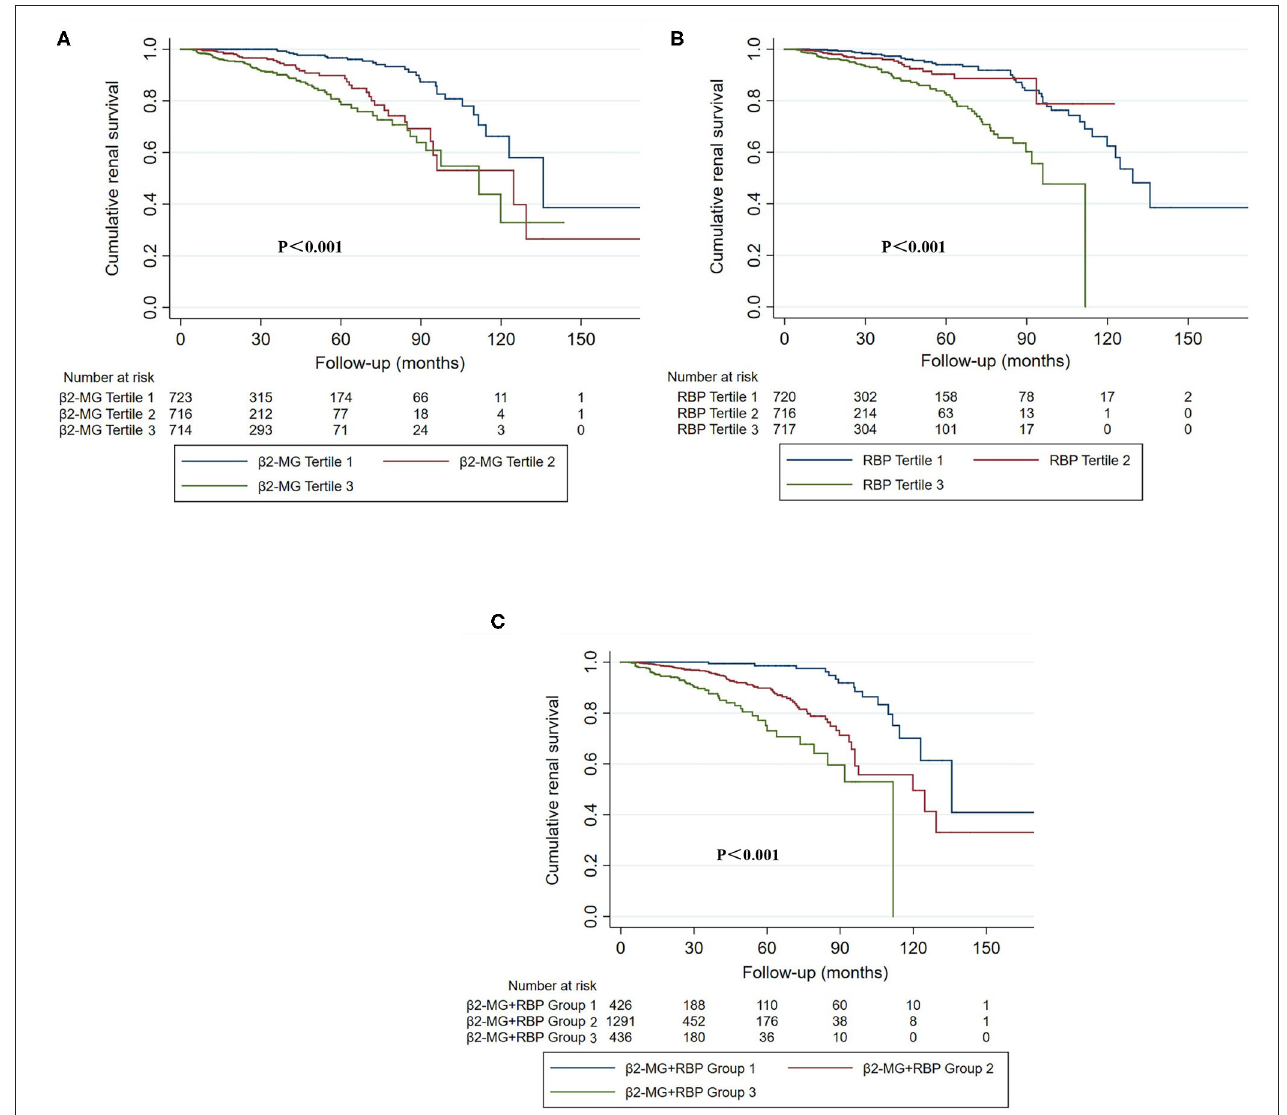
FIGURE 3 | The Kaplan–Meier curves of cumulative renal survival stratified by urinary β 2-MG (A) , urinary RBP (B) , tertiles and the combination of β 2-MG and RBP (C) . (A) Tertile 1: the first tertile, urinary β 2-MG was 20.0 mg/mol Cr [interquartile range (IQR), 10.0–30.0]; tertile 2: the second tertile, urinary β 2-MG was 56.0 mg/mol Cr (IQR, 45.0–74.0); tertile 3: the third tertile, urinary β 2-MG was 220.0 mg/mol Cr (IQR, 128.0–418.0). (B) Tertile 1: the first tertile, urinary RBP was 110.0 mg/mol Cr (IQR, 25.0–270.5); tertile 2: the second tertile, urinary RBP was 783.5 mg/mol Cr (IQR, 607.5–1014.8); tertile 3: the third tertile, urinary RBP was 2799.0 mg/mol Cr (IQR, 1774.5–4766.5). (C) Group 1: patients in both the first β 2-MG and the first RBP tertiles; Group 3: patients in both the third β 2-MG and the third RBP tertiles; Group 2: the others.